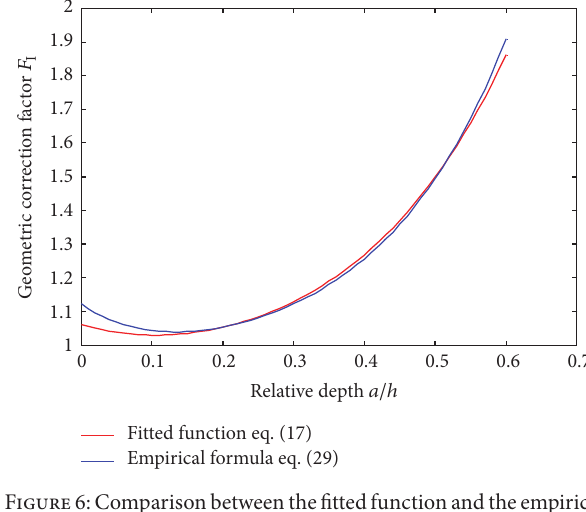
Figure6:Comparisonbetweenthefittedfunctionandtheempirical